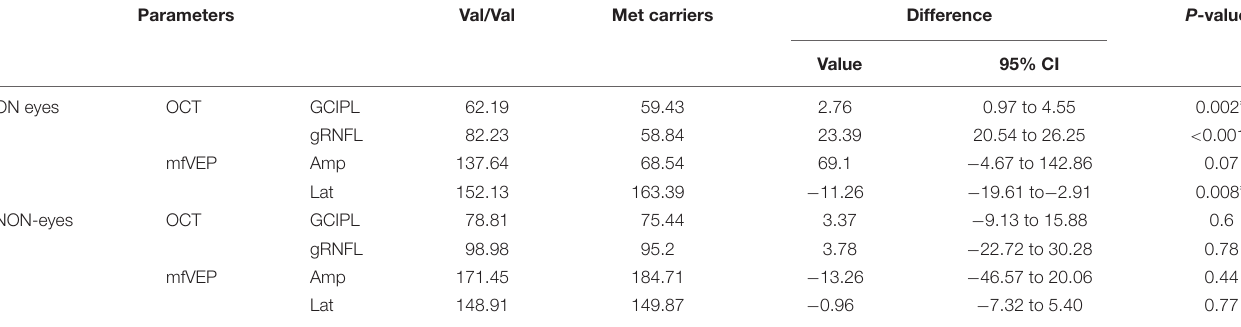
TABLE 2 | Association between BDNF Val66Met polymorphism and optic nerve damage in NMOSD. Parameters Val/Val Met carriers Difference P -values Value 95% CI